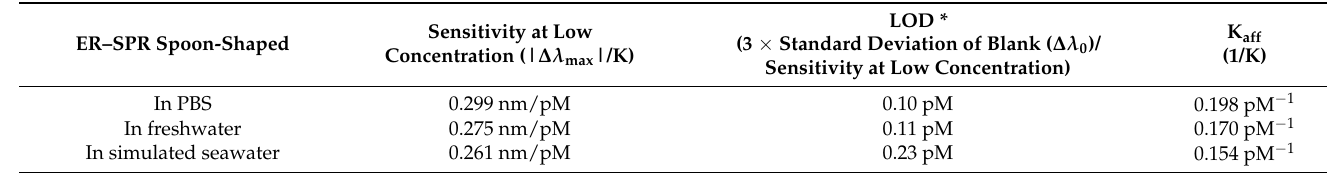
Table 2. ER–SPR spoon-shaped analytical parameters relative to estradiol